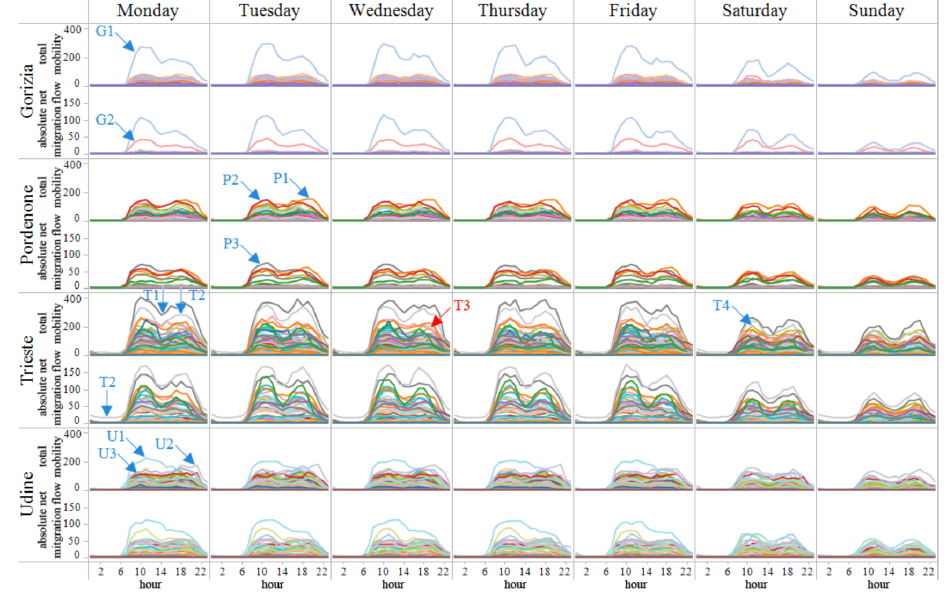
Figure 6. Sparklines visualization of temporal variation of total mobility and net migration flow on each urban center